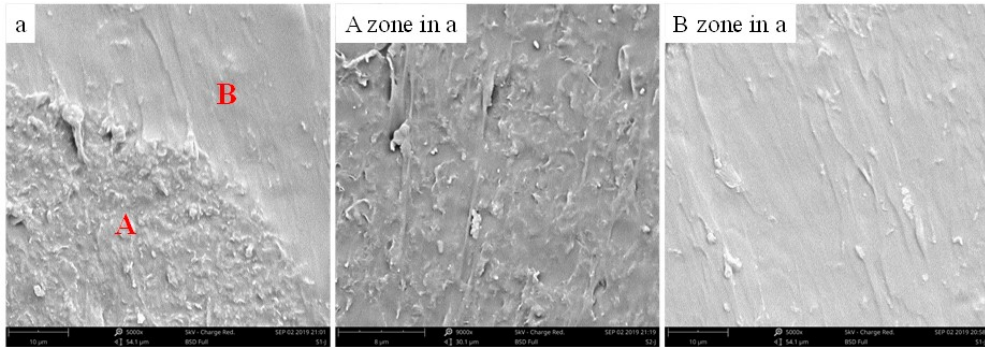
Figure 15. Cross-sectional SEM images of the self-healing composite film, A zone is the zone without crack, and B zone is the zone of self-healing of scratch.